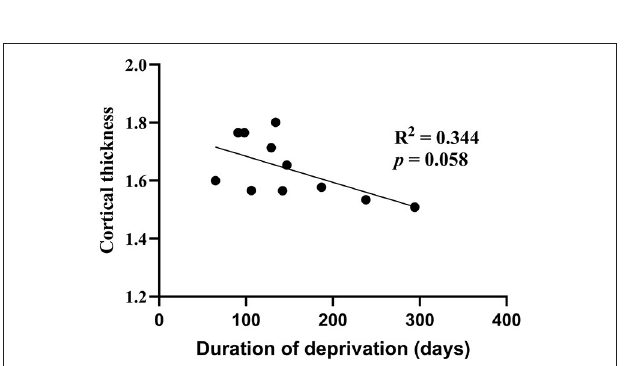
FIGURE 4 | Correlation of cortical thickness (mm) between the left calcarine sulcus and duration of deprivation (days) in cataract-reversal patients ( N = 11).